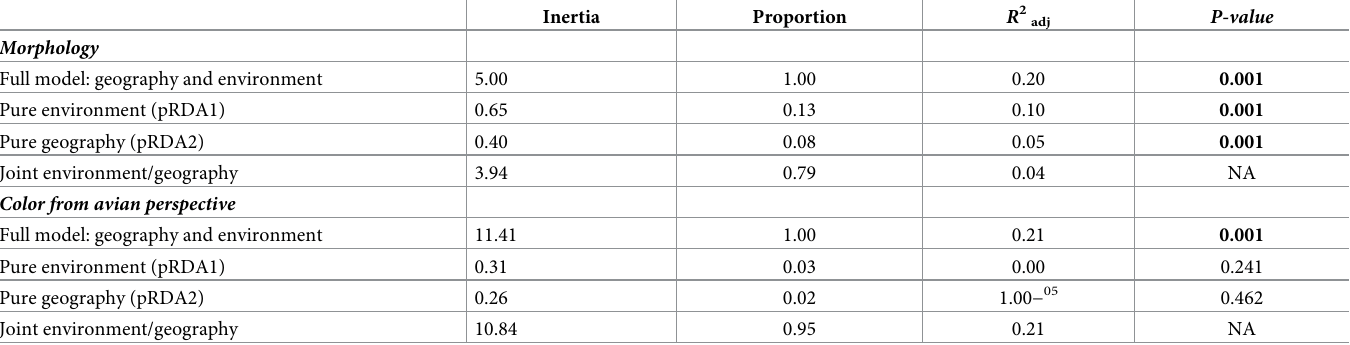
Table 4. Results of the redundancy analysis (RDA) for the association between phenotypic variation (morphology and color from the avian perspective), geographic and environmental variables for Thryophilus sinaloa